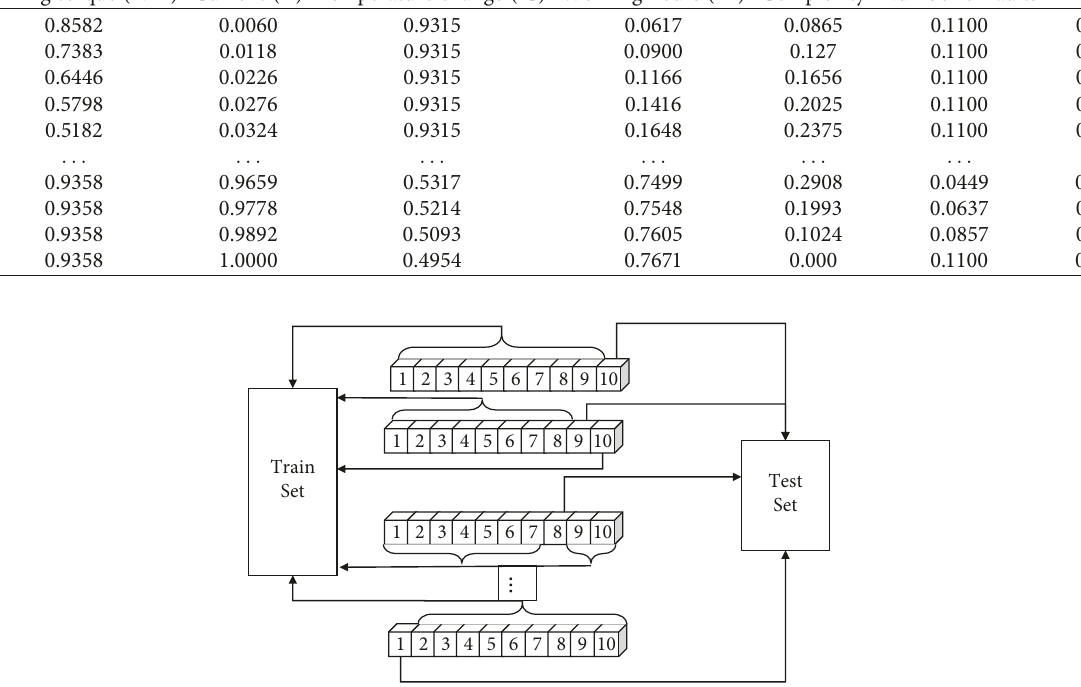
Figure 5: Method of homogenizing sampling